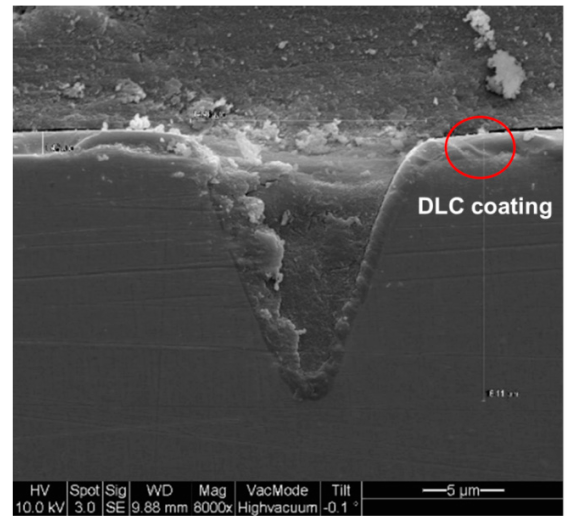
Figure 7. The Scanning electron microscope (SEM) cross-section picture of diamond like carbon (DLC) coating layer.